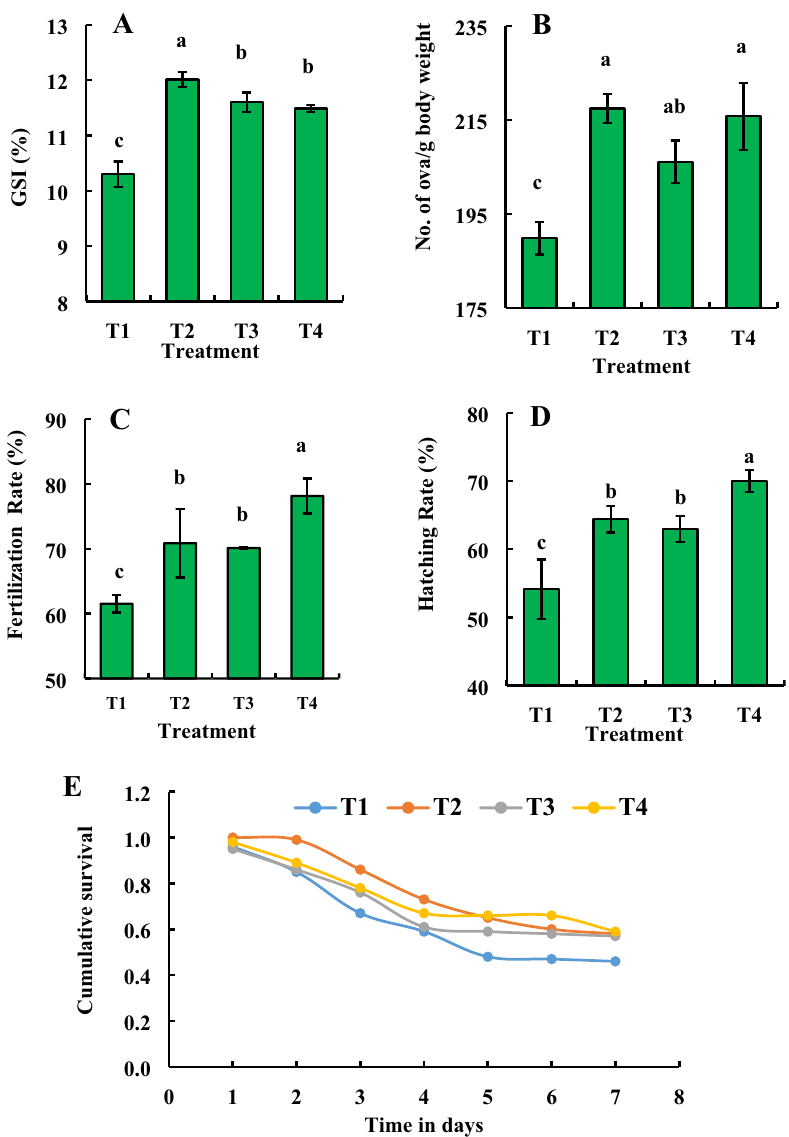
Figure 10. Assessment of consortium effects of probiotic bacterial strains viz . GFB-1, GFB-2, GFB-3, GFB-4 and GFB-5 isolated from the gut of B. gonionotus on reproductive performances (A, B, C, D and E) of the host fish. The fishes were stoked at 16 each replication at ratio of 1:3 of male and female for assessing (A) gonadosomatic index (GSI), (B) no. of ova/g body weight, (C) fertilization rate, (D) hatching rate and (E) cumulative survival of larva with a with a 95% CI (n = 100). One way ANOVA was performed for analyzing the data of three replicated experiment and data in column varies significantly in LSD at P < 0.05 (Statistix 10). Different letter bars indicate significant variations in GSI, no. of ova/ g body weight, fertilization rate, hatching rate and survival rate of hatchlings of the host fish by the isolates at P < 0.05 (Statistix 10). Error bar = ± SD; n =